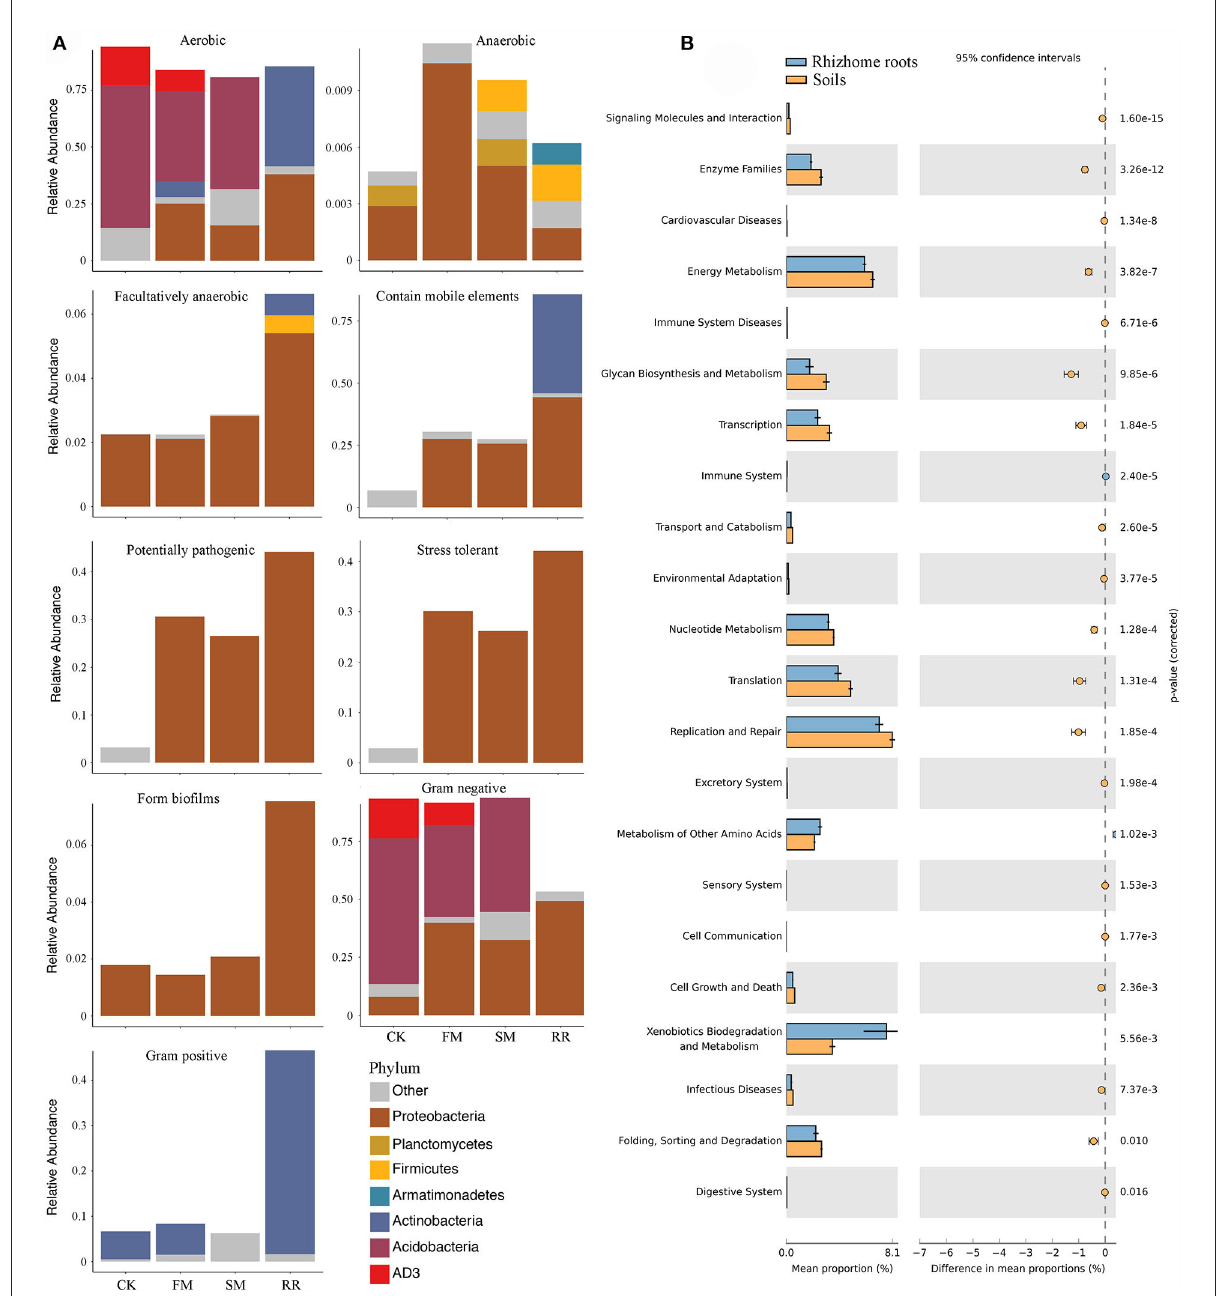
FIGURE6 Biologically interpretable phenotypes and functional analysis of Moso bamboo-associated bacteria after combined intensive management. (A) Biological phenotypes predicted by BugBase; (B) Significantly different pathways between rhizome roots and soil bacterial microbiota at KEGG functional category 2 with their statistical significance estimated in